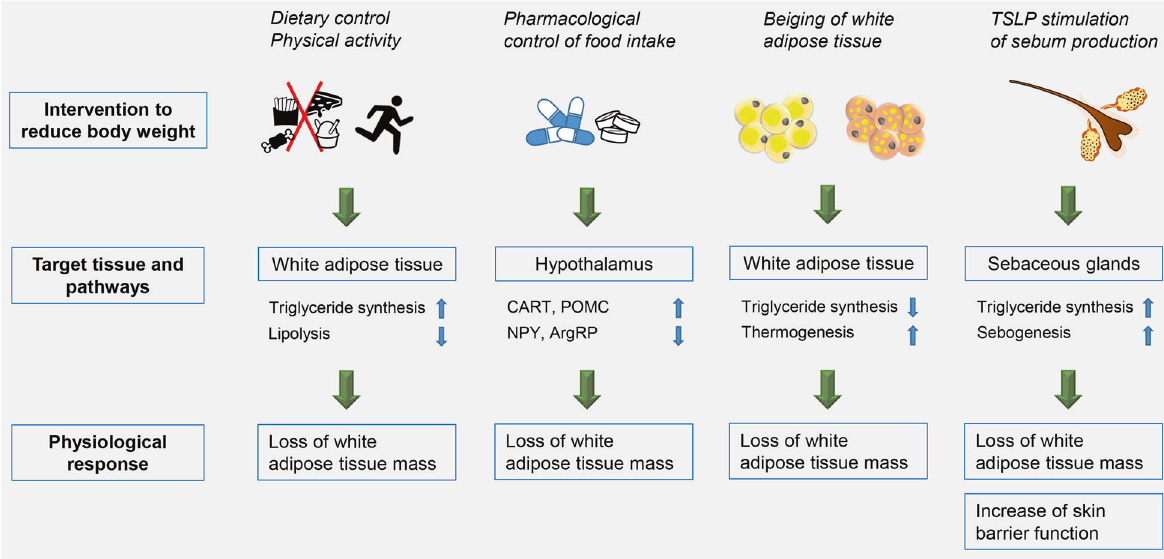
Fig. 1 Strategies to reduce adipose. Restriction of calorie intake and promotion of physical activity directly require individual initiative and action, while pharmacological interventions passively aim to decrease food uptake, e.g., via orexigenic (NPY, neuropeptide Y; AgRP, agouti- related peptide) or anorexigenic (CART, cocaine- and amphetamine-related transcript; pro-opiomelanocortin, POMC) neuropeptides. Beiging of white adipose tissue by, e.g., cold stress addresses fat depot breakdown via thermogenesis. TSLP activation of sebum production “ sucks ” off lipids from adipose tissue, but in addition impacts on skin barrier homeostatic